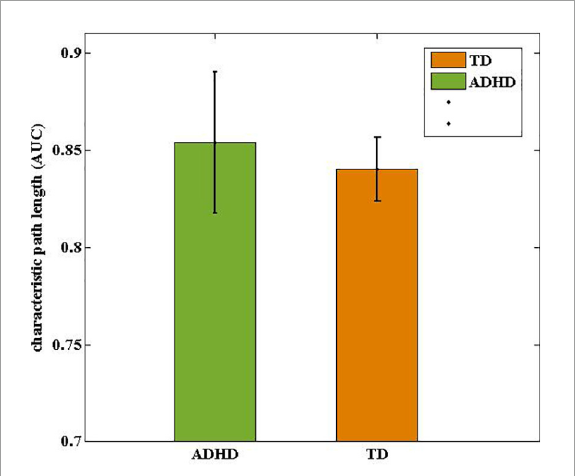
FIGURE4 Comparisons of drug-naive ADHD children and TD controls in terms of characteristic path length (Lp). The characteristic path length in ADHD group was statistically longer than in the TD